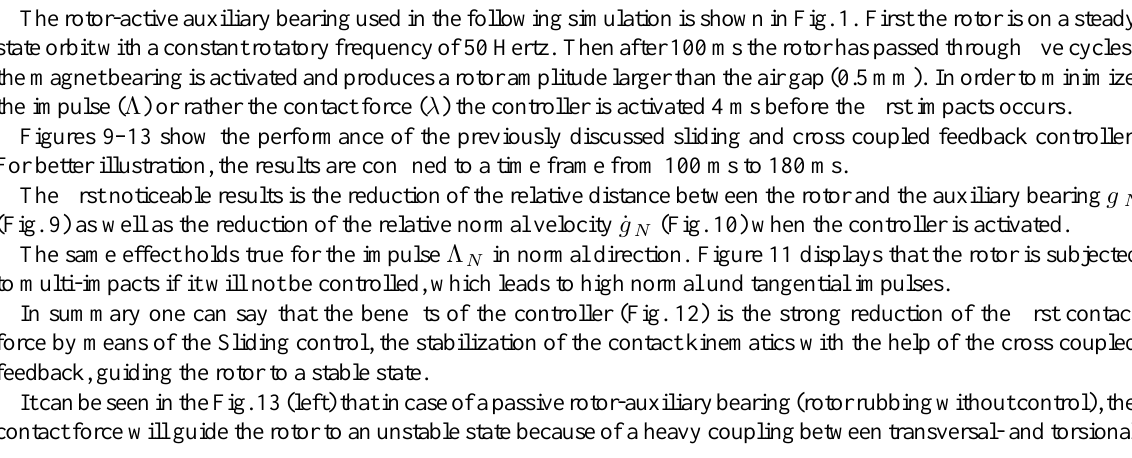
Fig. 10. Relative normal